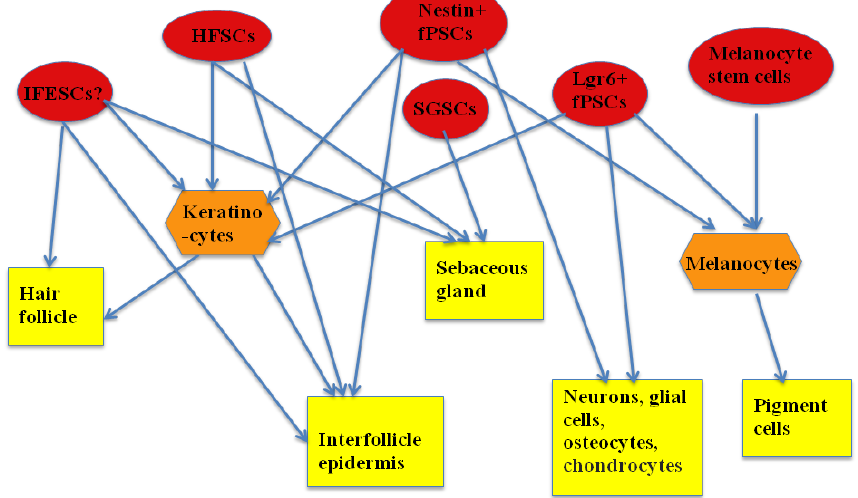
Figure 1. The population of epidermal stem cells (ESCs) and their progenies. The arrow illustrates differentiation from the stem (in red oval)/progenitor cells (in orange hexagonal) to the progeny, or the relation between the stem cells and the tissue, whose renewal the stem cells participate in. IFESCs, interfollicle epidermis stem cells; HFSCs, hair follicle stem cells; fPSCs, follicle pluripotent stem cells; SGSC, sebaceous gland stem cells. ―IFESCs?‖ represents a controversy in